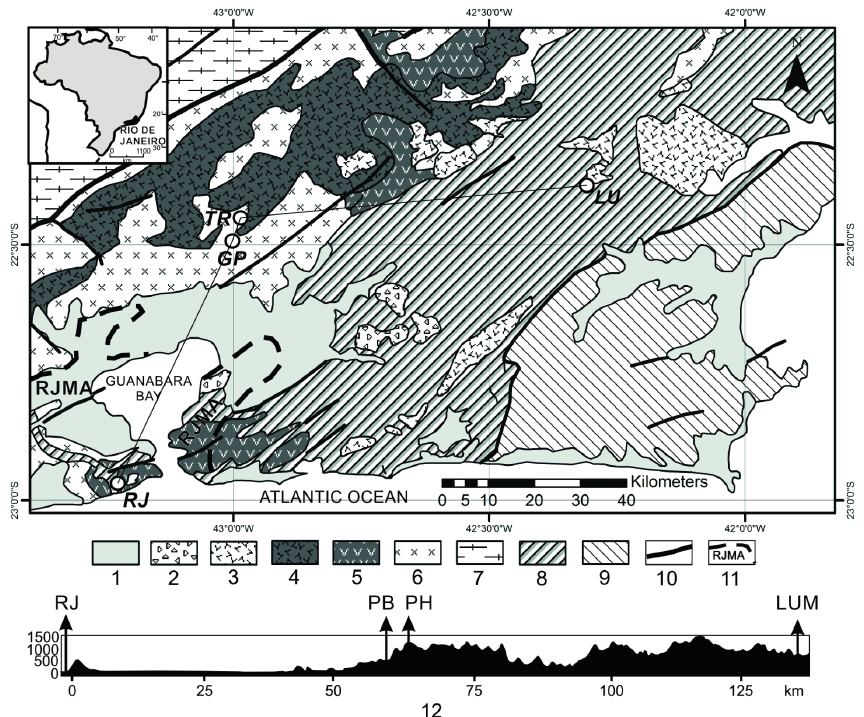
Figure 1 - Map of the Central and North Region of Rio de Janeiro State, showing the geological and topographical setting of the study area and the sampling sites of epiphytes (circle). Geological information: 1. Cenozoic deposits, 2. KT igneous alkaline rocks, 3. biotite granites